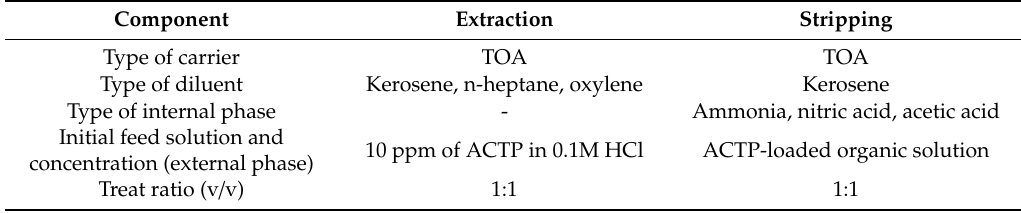
Table 1. Parameters and conditions for screening of emulsion